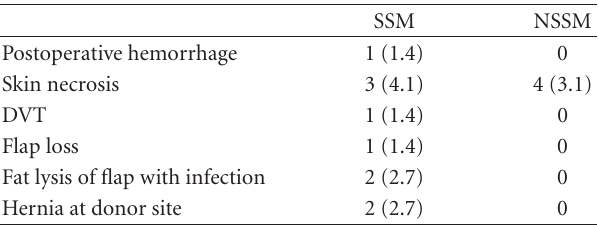
Table 5: Complications in SSM and NSSM (%). Table 6: Relation between smoking and complications in SSM